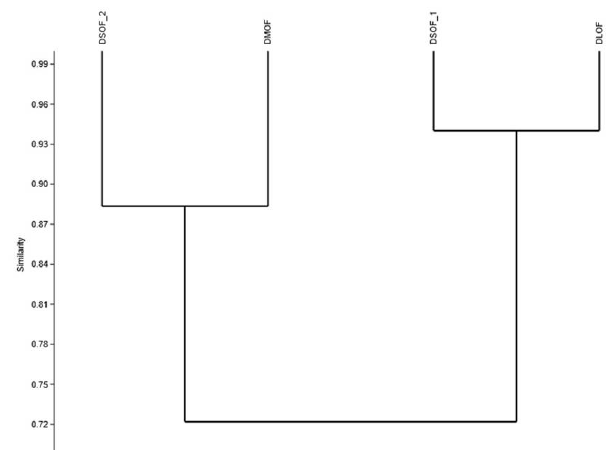
Fig 2. Similarity index (Jaccard) for species composition of four areas in the Brazilian Atlantic forest. DLOF: dense lowland ombrophilous forest), DSOF_1: dense submontane ombrophilous forest, area 1, DSOF_2: dense submontane ombrophilous forest, area 2, DMOF: dense montane ombrophilous forest.